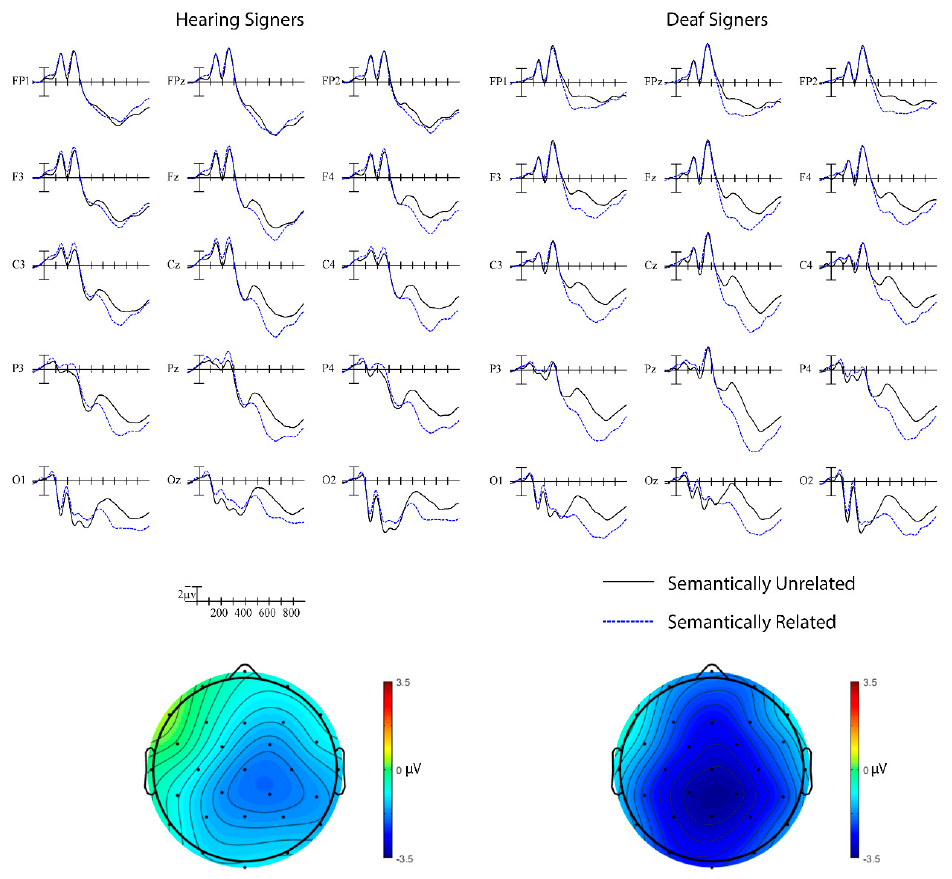
Figure 3. Semantic priming effects in hearing and deaf signers. Grand average ERP waveforms elicited by targets in semantically unrelated (black) and semantically related (blue) pairs at 15 sites. Each vertical tick marks 100 ms and negative is plotted up. The calibration bar marks 2 µV. Scalp voltage maps showing the semantic priming effect on mean N400 amplitude (unrelated–related) from 325–625 ms.